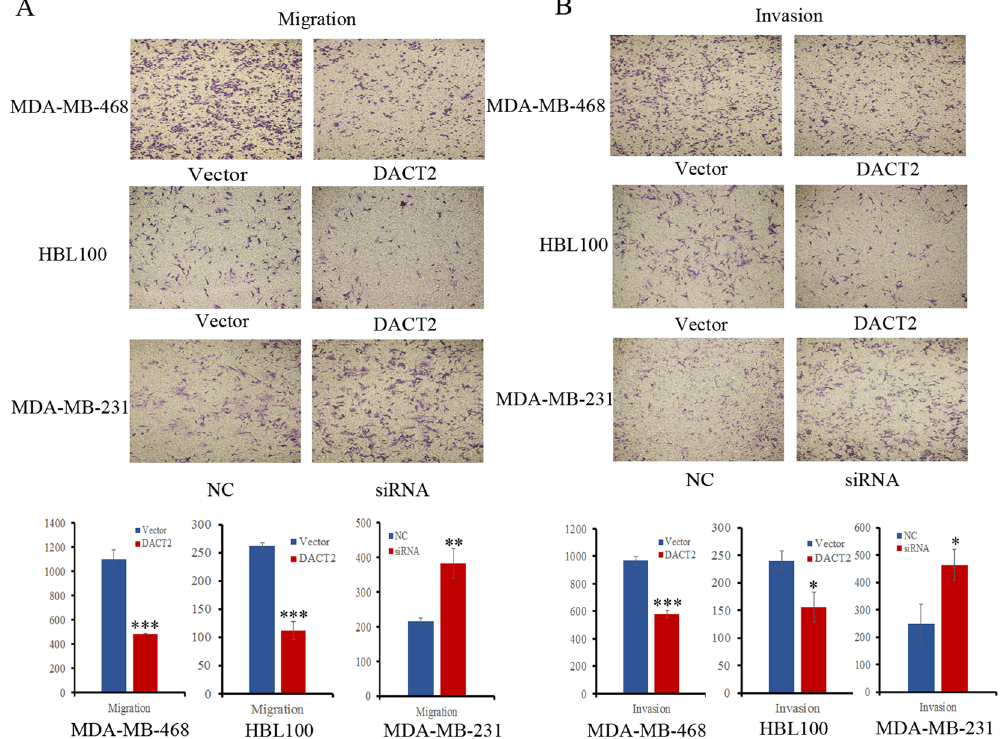
Figure 4. The effects of DACT2 on breast cancer cell migration and invasion ( A ) Transwell results show cell migration in DACT2 unexpressed and re-expressed MDA-MB-468 and HBL100 cells, as well as migration of MDA-MB-231 cells before and after knockdown of DACT2. Each experiment was repeated three times. ** P < 0.01, *** P < 0.001 ( B ) Transwell results show cell invasion in DACT2 unexpressed and re-expressed MDA-MB-468 and HBL100 cells, as well as invasion of MDA-MB-231 cells before and after knockdown of DACT2. Each experiment was repeated three times. * P < 0.05, *** P <